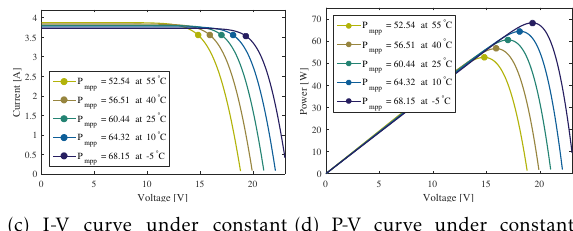
Figure 2. I-V and P-V curves of a PV panel. (a) and (b) presents the I-V and P-V curves for different values of irradiance keeping temperature constant at 25 ◦ C . (c) and (d) presents the I-V and P-V curves for different values of temperature keeping irradiance level at 1000 W /m 2 .